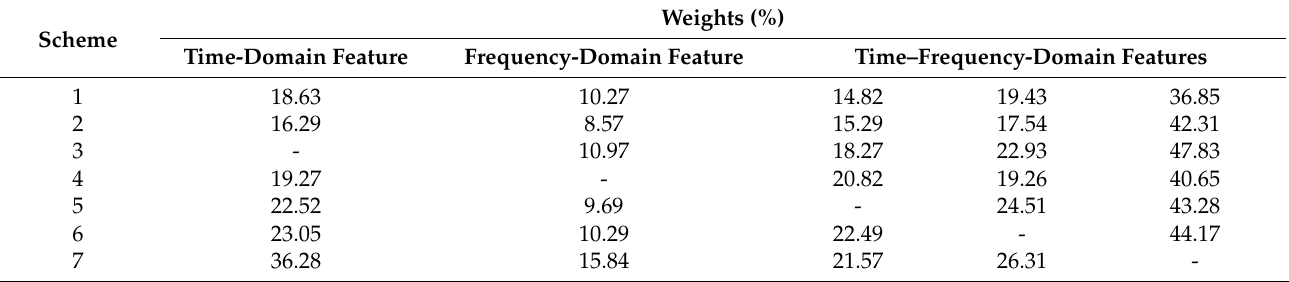
Table 9. Weights of different features of seven features fusion methods.